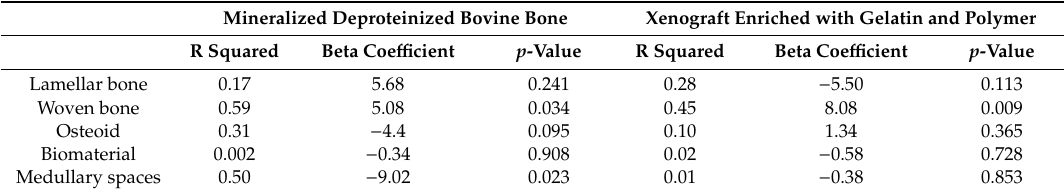
Table 2. Results of linear